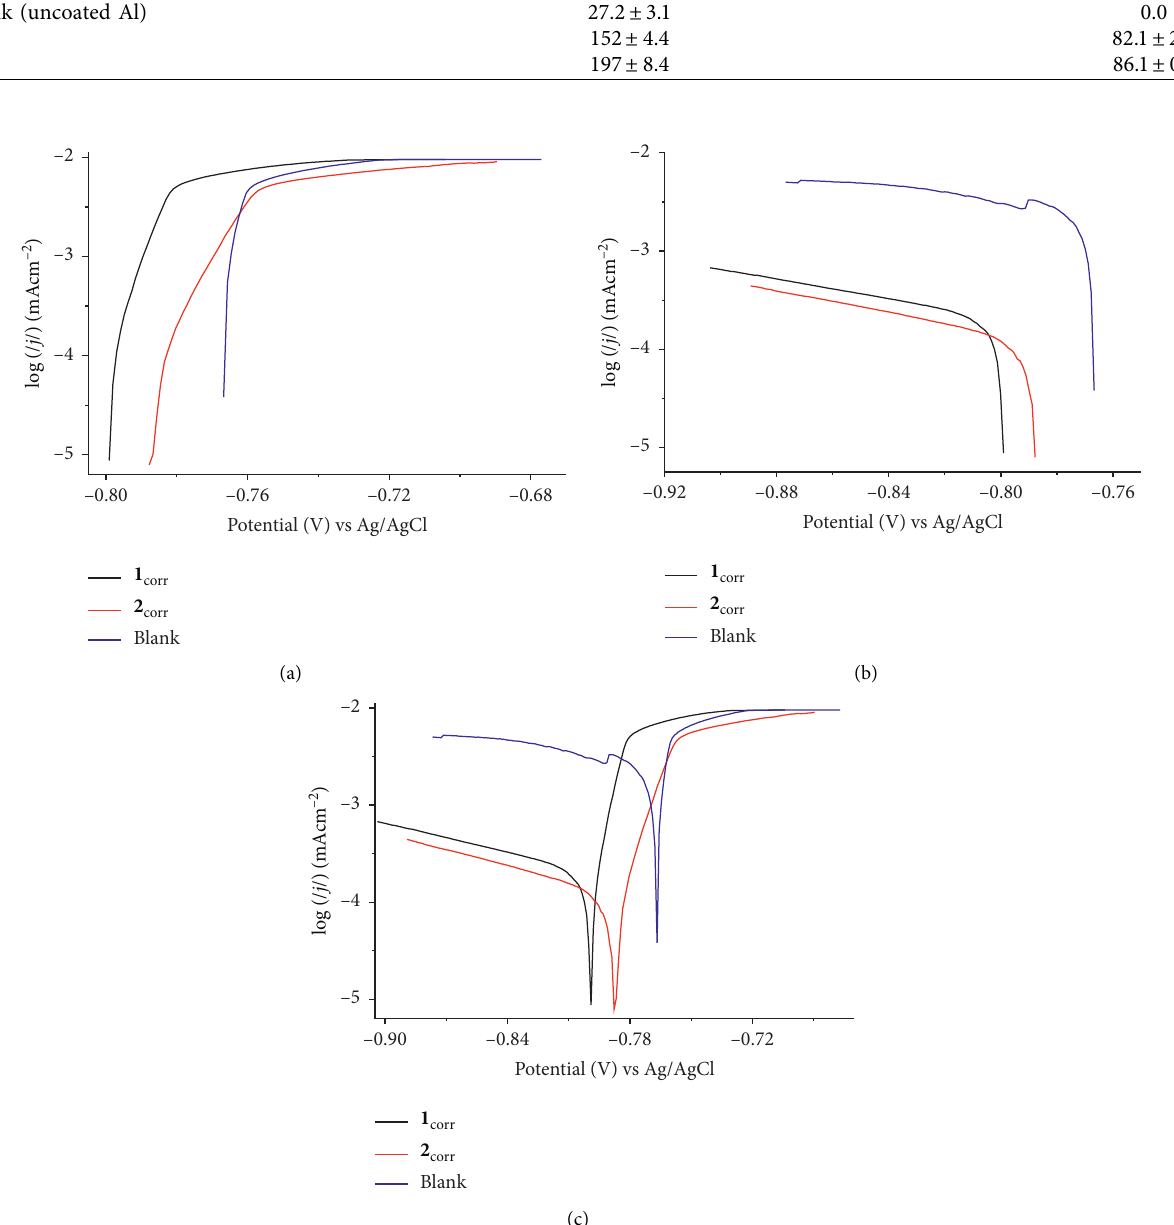
Figure 7: Anodic (a) and cathodic (b) branches and polarization curves (c). 1 electrodeposited- 1 and electrodeposited- 2 immersed in 1.0 M hydrochloric acid solution for 30 min period and at room temperature 28 ° C ± 0.05 °